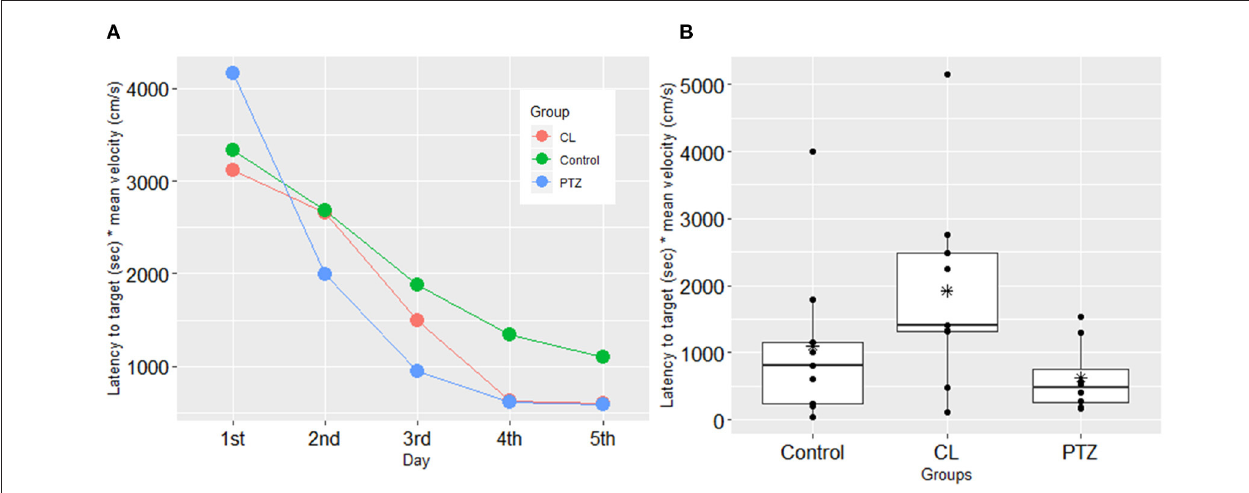
FIGURE 3 | Spatial learning in the water maze test in the three groups. (A) In the training session, no significant difference was found in the latency to the target platform (s) multiplied by mean velocity (cm/s); (B) in the testing session, no significant difference was shown in the latency to the target platform (sec) multiplied by mean velocity (cm/s) in the testing session. The symbol * represents the mean of each group.